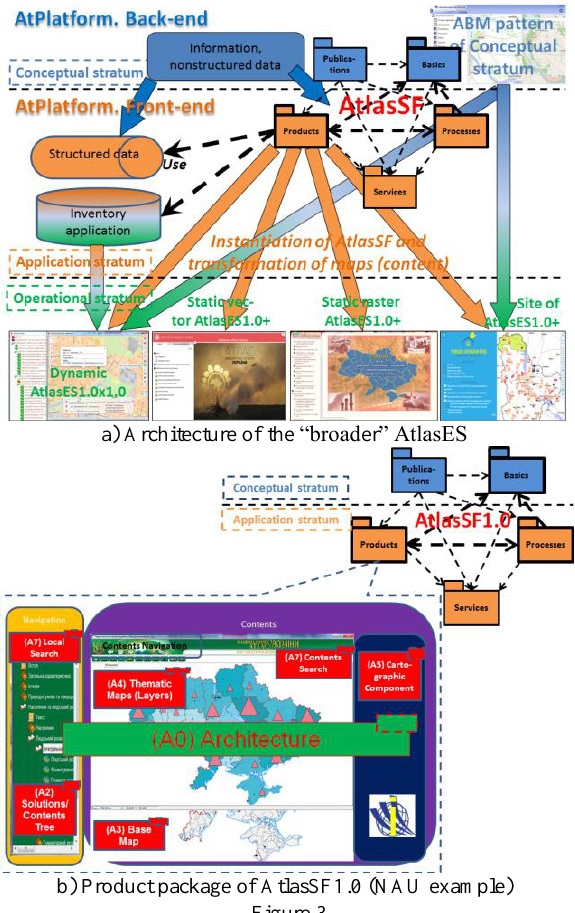
AtlasES is built on the so-called Atlas platform (AtPlat- form, AP), which consists of Back-end and Front-end.